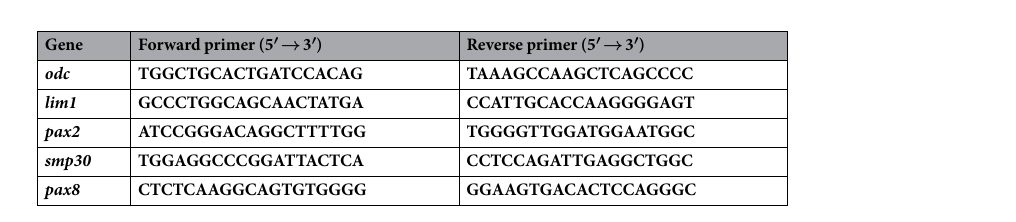
Table 2. Primers used for real time